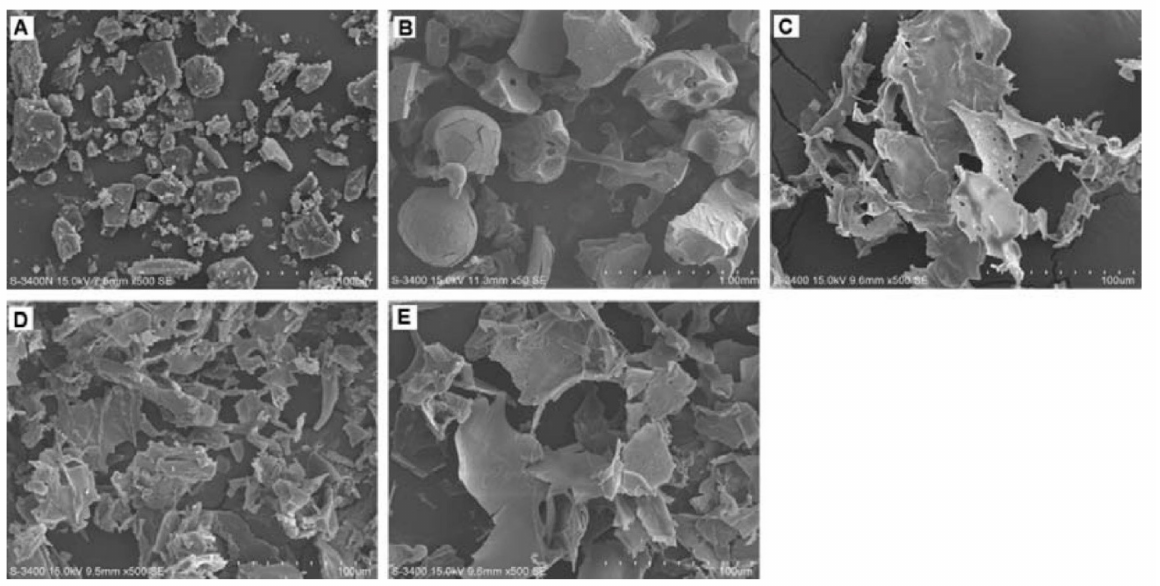
Figure 27. The SEM photographs of β -CD ( A ), CM-HP- β -CD ( B ), OVA ( C ), OVA- β -CD inclusion complex ( D ), and OVA- CM-HP- β -CD inclusion complex ( E ) [173]. Reproduced with permission from Elsevier